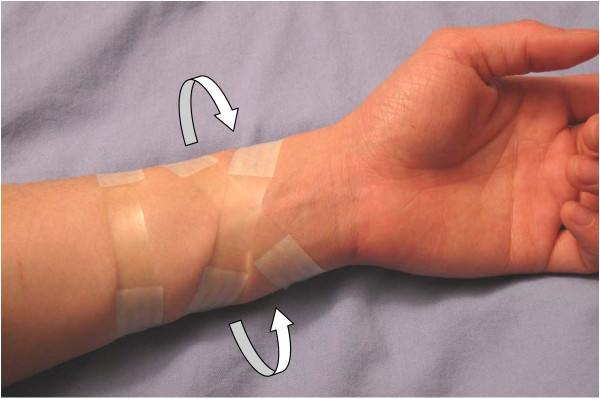
Tension tapes on the treatment arm. Typical application of tension tapes on the planned donor arm. Note the transverse proximal tape and the crisscross arrangement of the two distal tapes. Also note that the elastic portion of the tape overlies the volar aspect of the forearm. Arrows show direction of force exerted by the elastic.